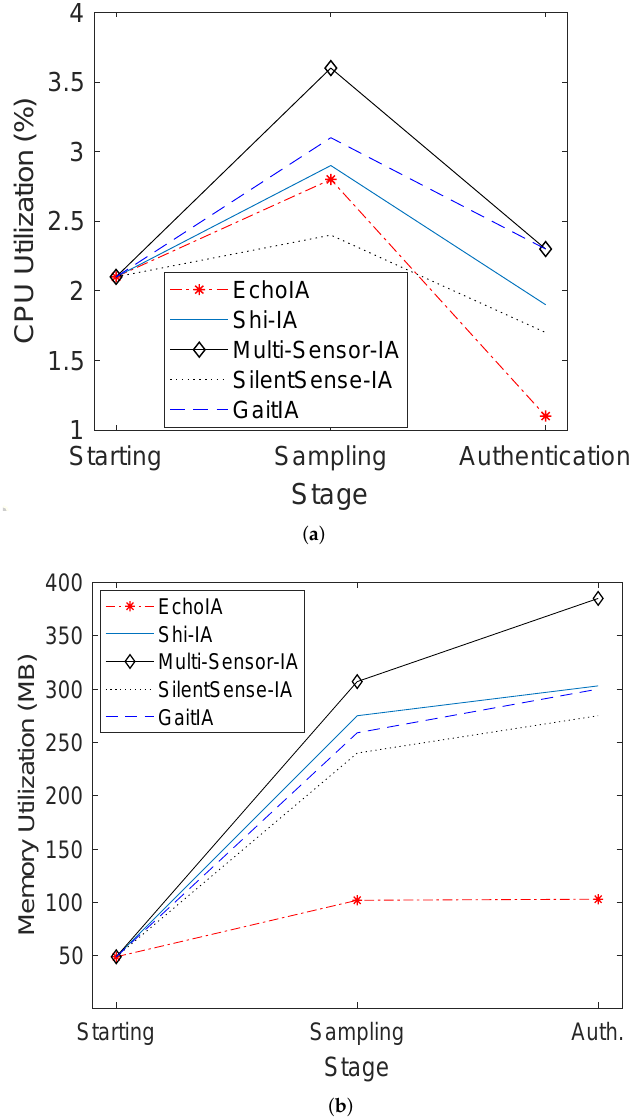
Figure 5. CPU Utilization and Memory Utilization (User-End). ( a ) CPU utilization. ( b ) Memory utilization. At the Starting stage, the user-end application and services begin to launch. At the Sam- pling stage, sensors’ data is sampled and periodically uploaded to the server. The Initialization phase is at the Sampling stage. At the authentication stage, utilizing the model returned from the server, the current user will be classified into two categories, legitimate or illegitimate. The Authentication phase is at this stage. Note that we connected different stages using lines in the figure to improve the readability. The stages are actually independent data